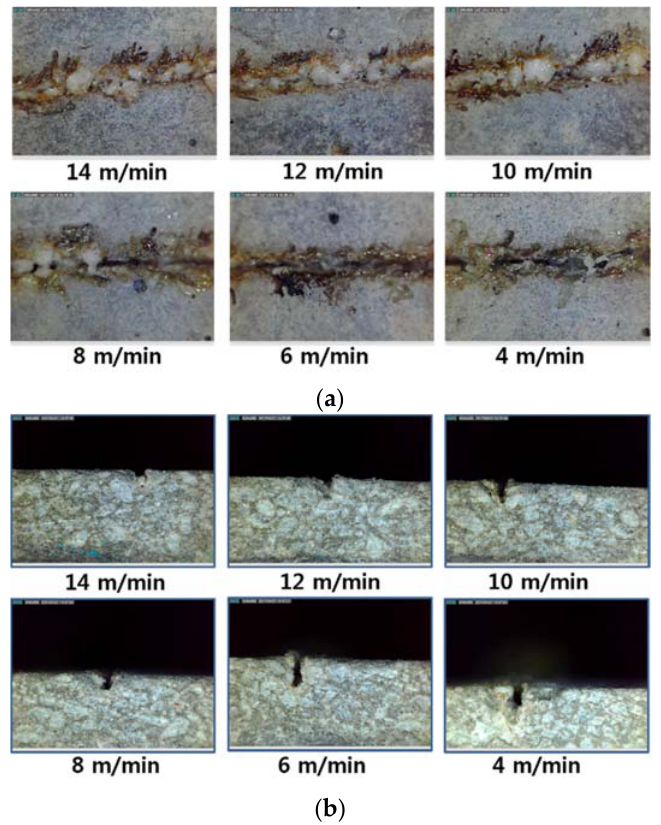
Figure 9. Kerf width ( a ) and penetration depth ( b ) vs. laser moving speed for LM1 ‐ 0.3.